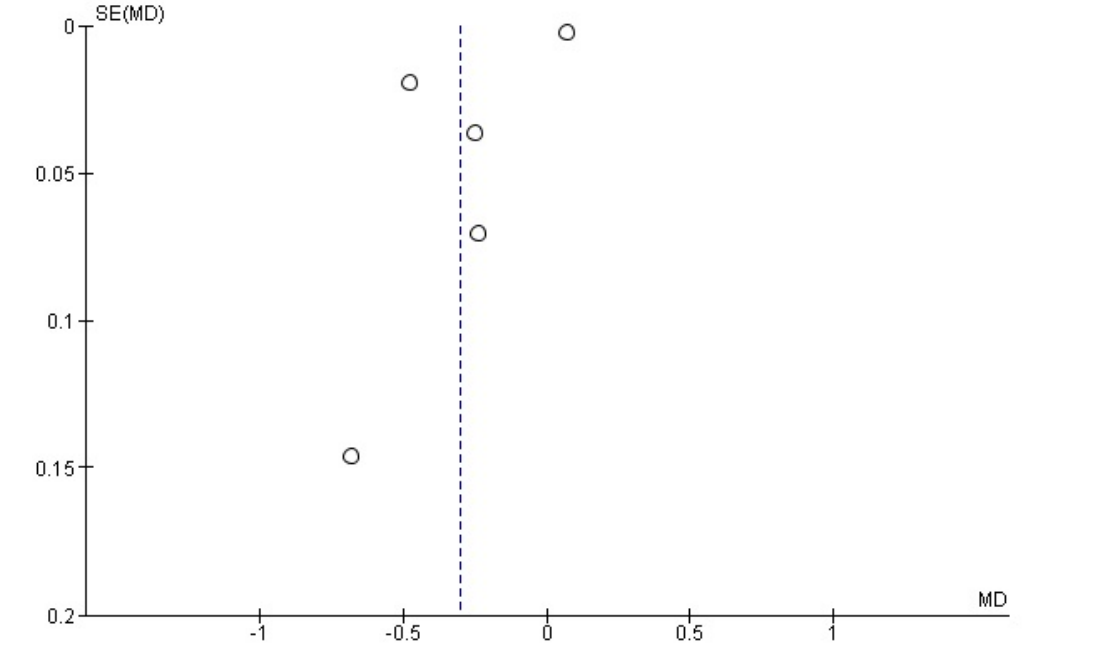
Figure 3. Funnel plots for ApoA1 levels in AD and healthy controls in included studies. Vertical dashed lines represent the summary weighted mean difference ( WMD).